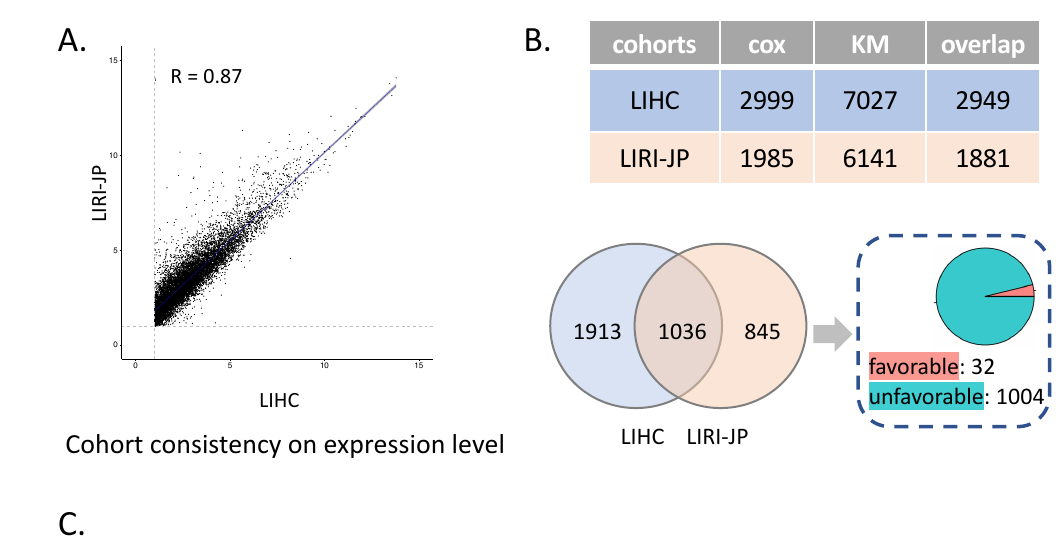
Figure 2. Identification and functional analysis of HCC SPGs